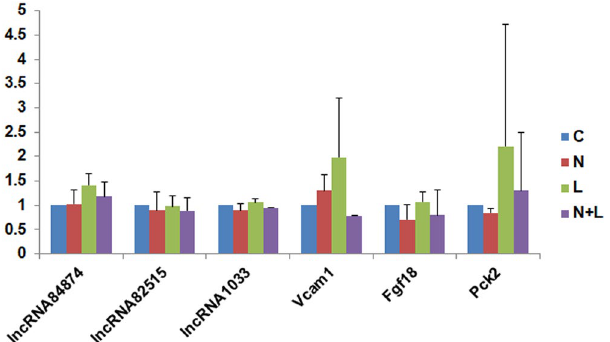
Figure 6. qRT-PCR validation of the sequencing results. The data showed that the relative expression level of genes fgf18 , Pck2 , Vcam1 , Wnt5a and Fos in sequencing (black) and qRT-PCR experiments (gray). The relative expression level of genes here represents the fold change of genes by normalizing the 2 −ΔΔCT value of each group by that of control group. The relative expression of fgf18 , Pck2 and Vcam1 in sequencing and qRT-PCR were consistent: the expression of fgf18 and Pck2 were significantly up-regulated, while the expression of Vcam1 was down regulated ( p <